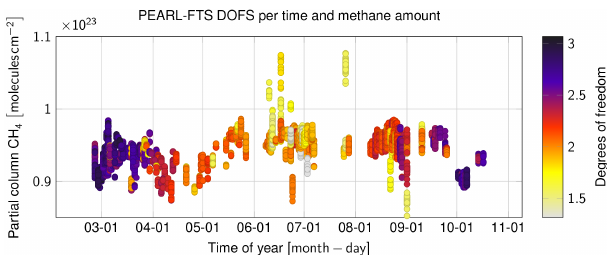
Figure 5. As in Fig. 4, but for PEARL-FTS. The vertical axis shows PEARL-FTS partial columns for 5.3–9.7km, but DOFS relate to the entire profile. The figure includes all 939 PEARL-FTS profiles collocated with TANSO-FTS. Note that the range of DOFS here is much larger than for Fig.